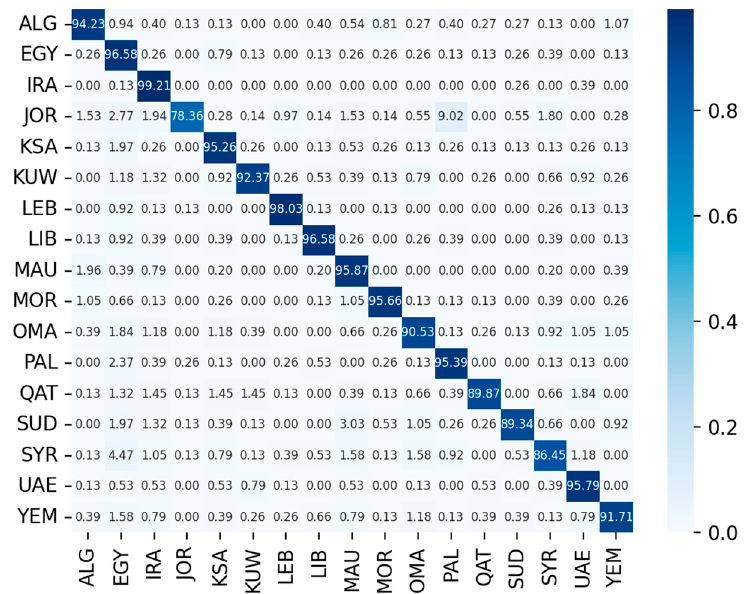
Figure 5. Dialect confusion matrix (speed perturbation).